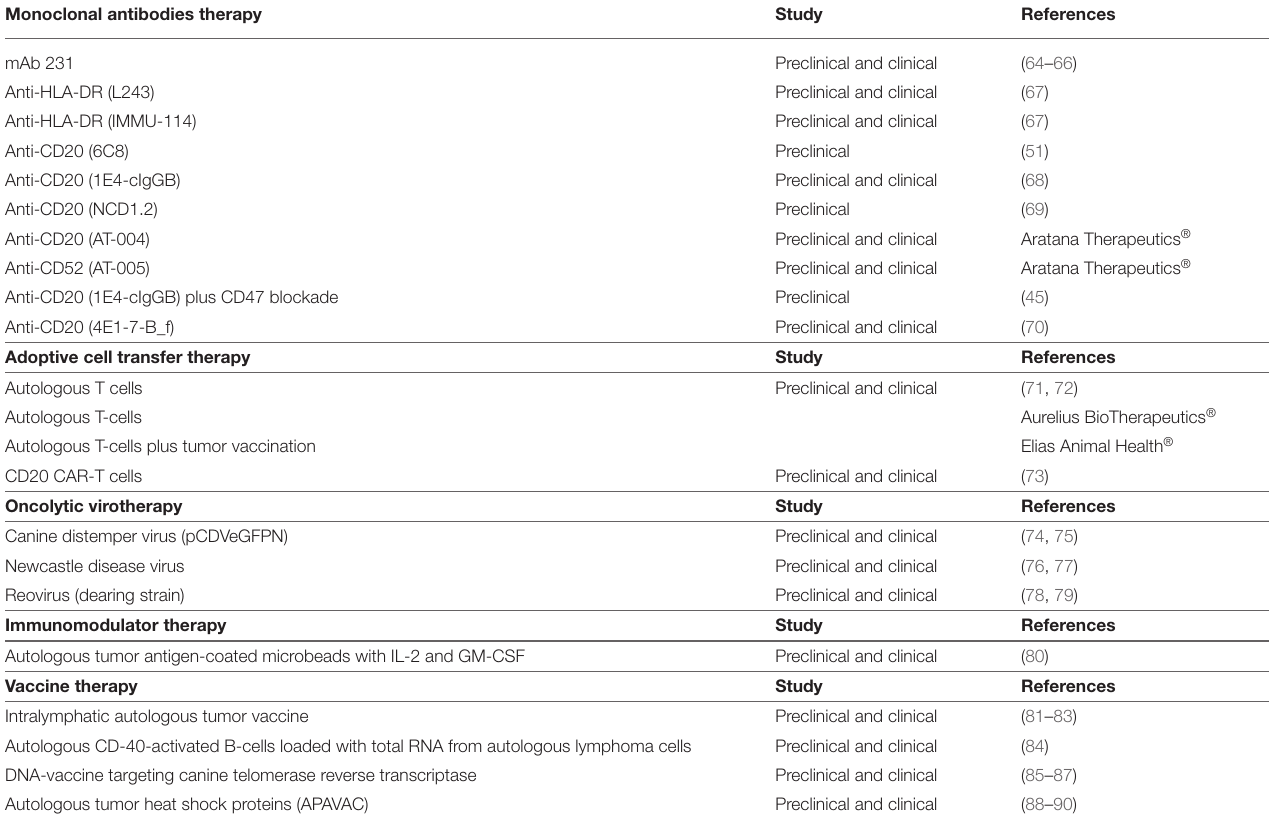
TABLE 1 | Immunotherapy approaches developed and under development for